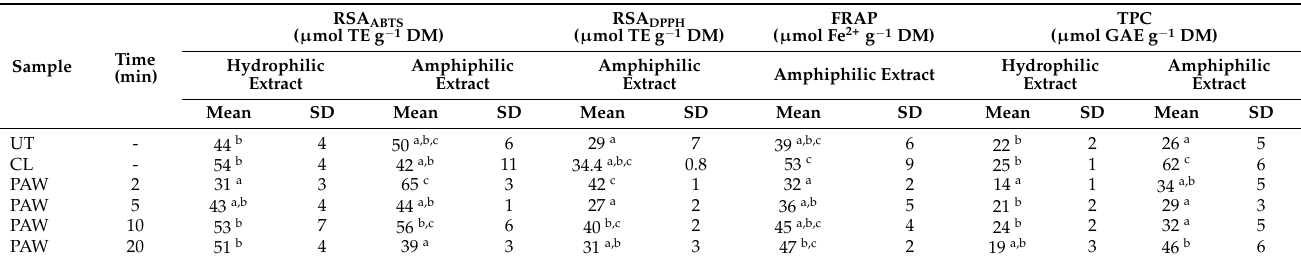
Table 1. Antioxidant activity in rocket salad samples evaluated by different in vitro methods as affected by PAW washing for different times. Data are expressed on dry matter (DM) as mean ± standard deviation (SD) of triplicate